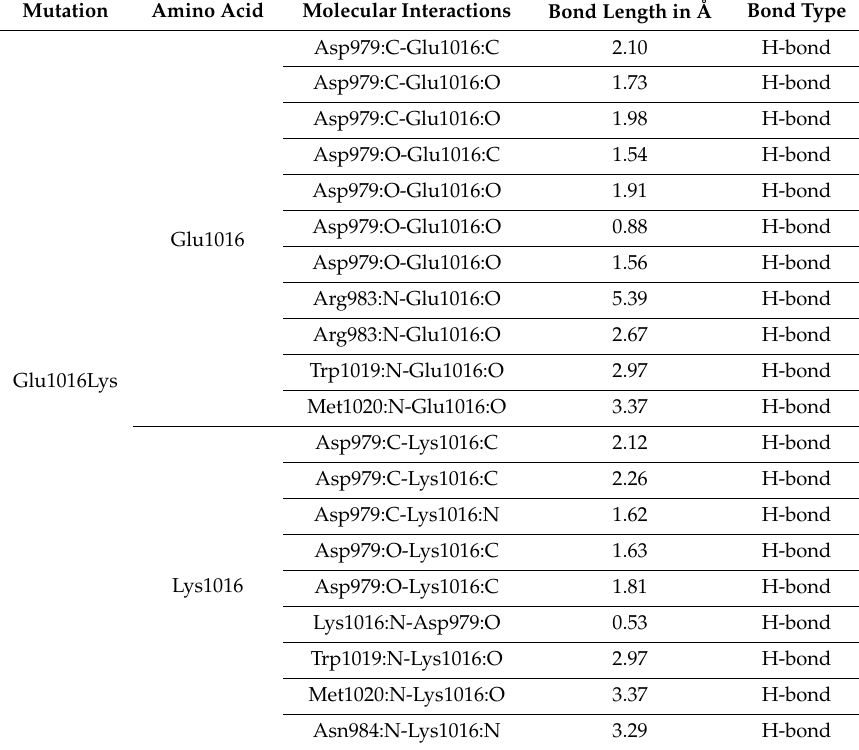
Table 7. Details of molecular interactions of Glu1016 and Lys1016 of the modeled TIE1 protein with adjacent residues.